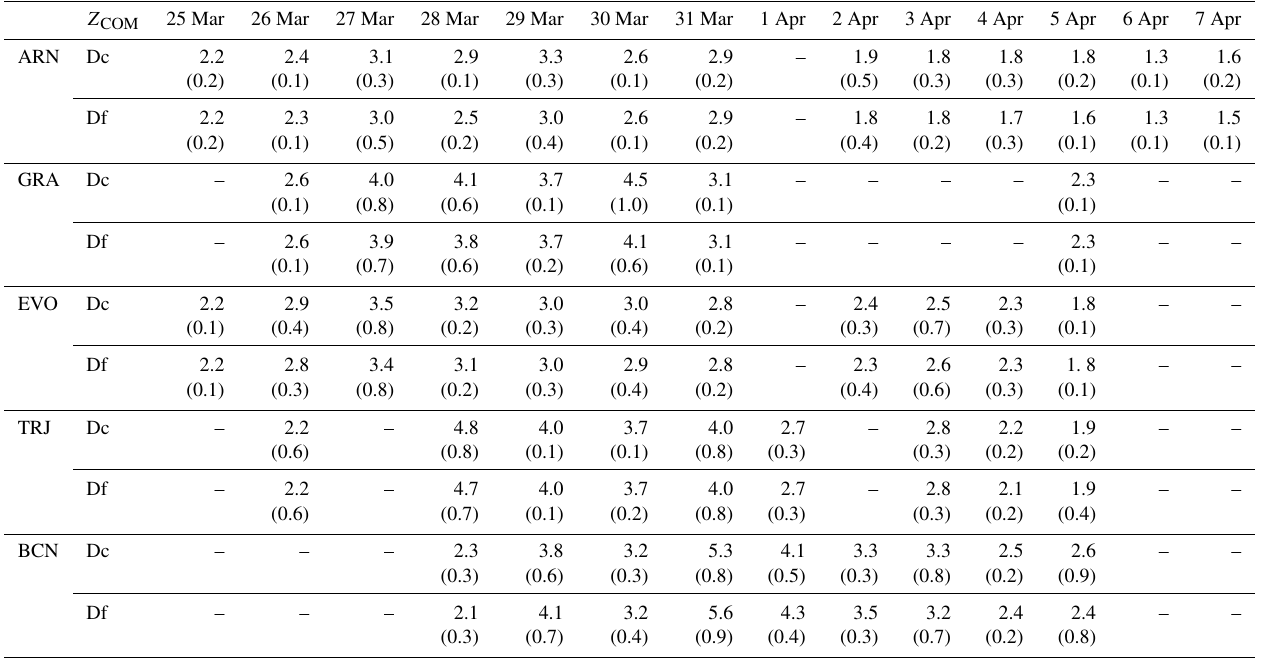
Figure 7. The same as Fig. 5, but for the relative mass loading of the Df particles (ftr_ M DD , in %) (left axis, in blue) and the total dust mass loading ( M DD , in gm − 2 ) (right axis, in purple). Table 3. Daily centre-of-mass height ( Z CoM , in kma.s.l.) for fine dust (Df) and coarse dust (Dc) particles along the particular dust periods for the five Iberian lidar stations (ARN, GRA, EVO, TRJ, and BCN). The standard deviation values are in